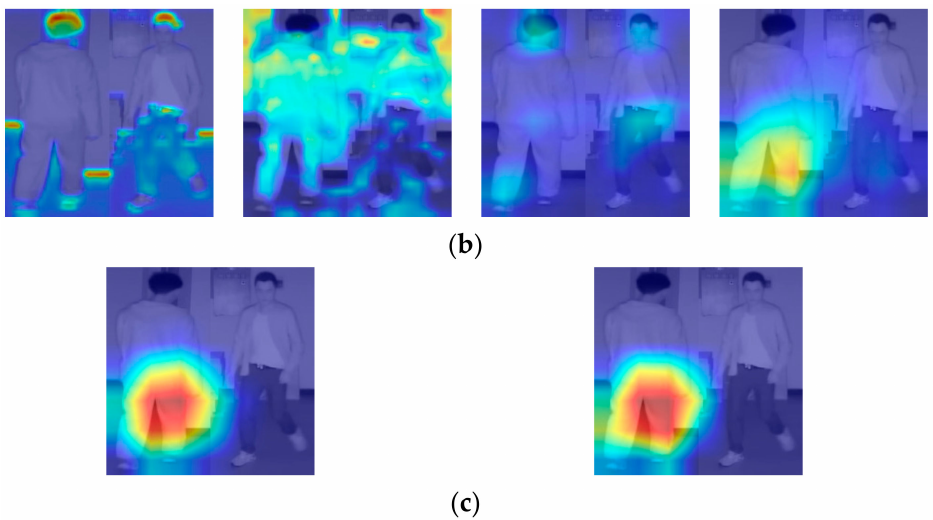
Figure 14. Grad-cam images obtained by the original DenseNet, attention-guided DenseNet, and SCE- Net, in the case of imposter matching. Grad-cam images extracted from ( a ) the original DenseNet and ( b ) the attention-guided DenseNet. Grad-cam images extracted from dense blocks 1 to 4 in Tables A1 and A2 (Appendix A) are arranged from left to right in ( a , b ). ( c ) Grad-cam images extracted from the SCE-Net in which the left-side images were extracted from conv layer 1 of Table A3 (Appendix A), while the right-side images were extracted from conv layer 2. In ( a – c ), the left-hand side of the composition image is the enrolled image, while the right-hand side is the input query image.